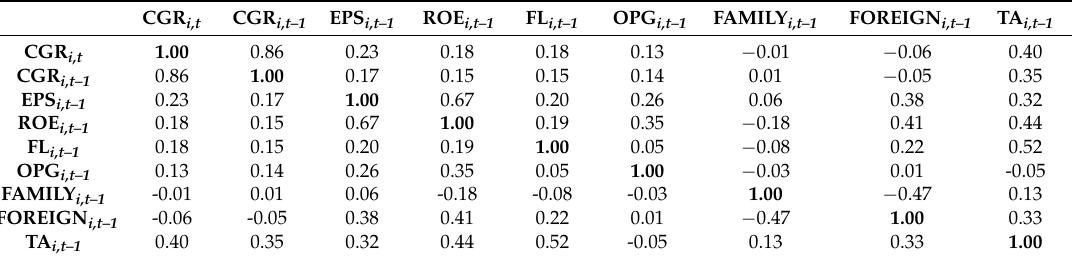
Table 3. Correlation Matrix.